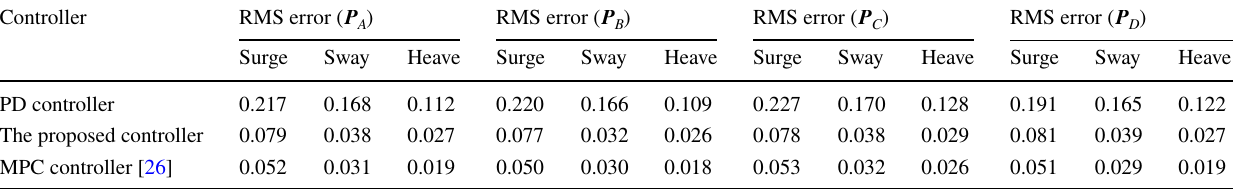
Fig. 8 AUV position trajectory for MPC controller [26], PD controller, and the proposed controller under measurement delay 0.723sin ( t ) s and t ) measurement noise 𝜻 ( Table 3 RMS errors (m) at the steady state for various controllers under measurement noise 𝜻 ( t ) and measurement delay 0.723sin ( t ) s Controller